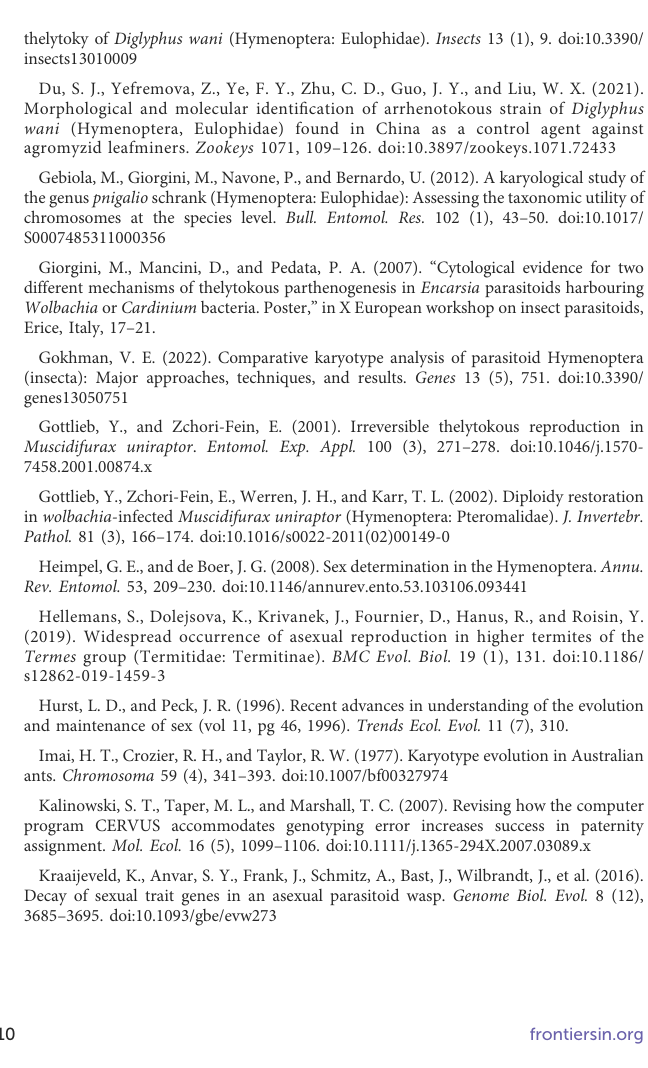
SUPPLEMENTARY TABLE S1 The polymorphic markers developed for thelytokous Diglyphus